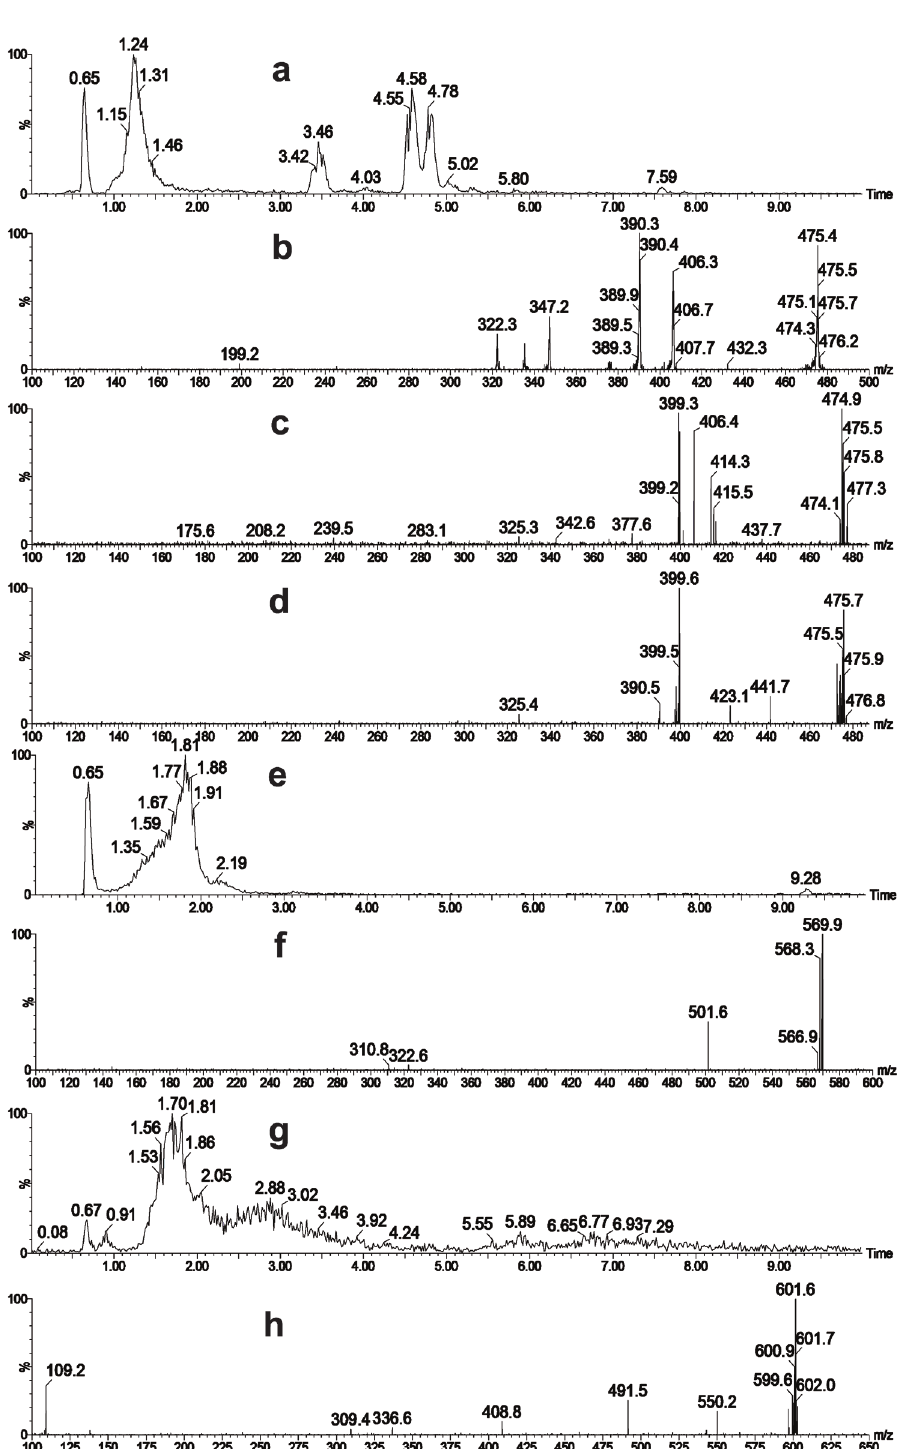
Figure 3 - Extracted ion UHPLC-MS chromatograms for ( a ) m/z 475, ( e ) m/z 569, and (g) m/z 601. MS/MS fragments for ions ( b ) m/z 475, retention time 1.5 min; ( c ) m/z 475, retention time 3.5 min; ( d ) m/z 475, retention time 4.8 min; ( f ) m/z 569; and ( h ) m/z